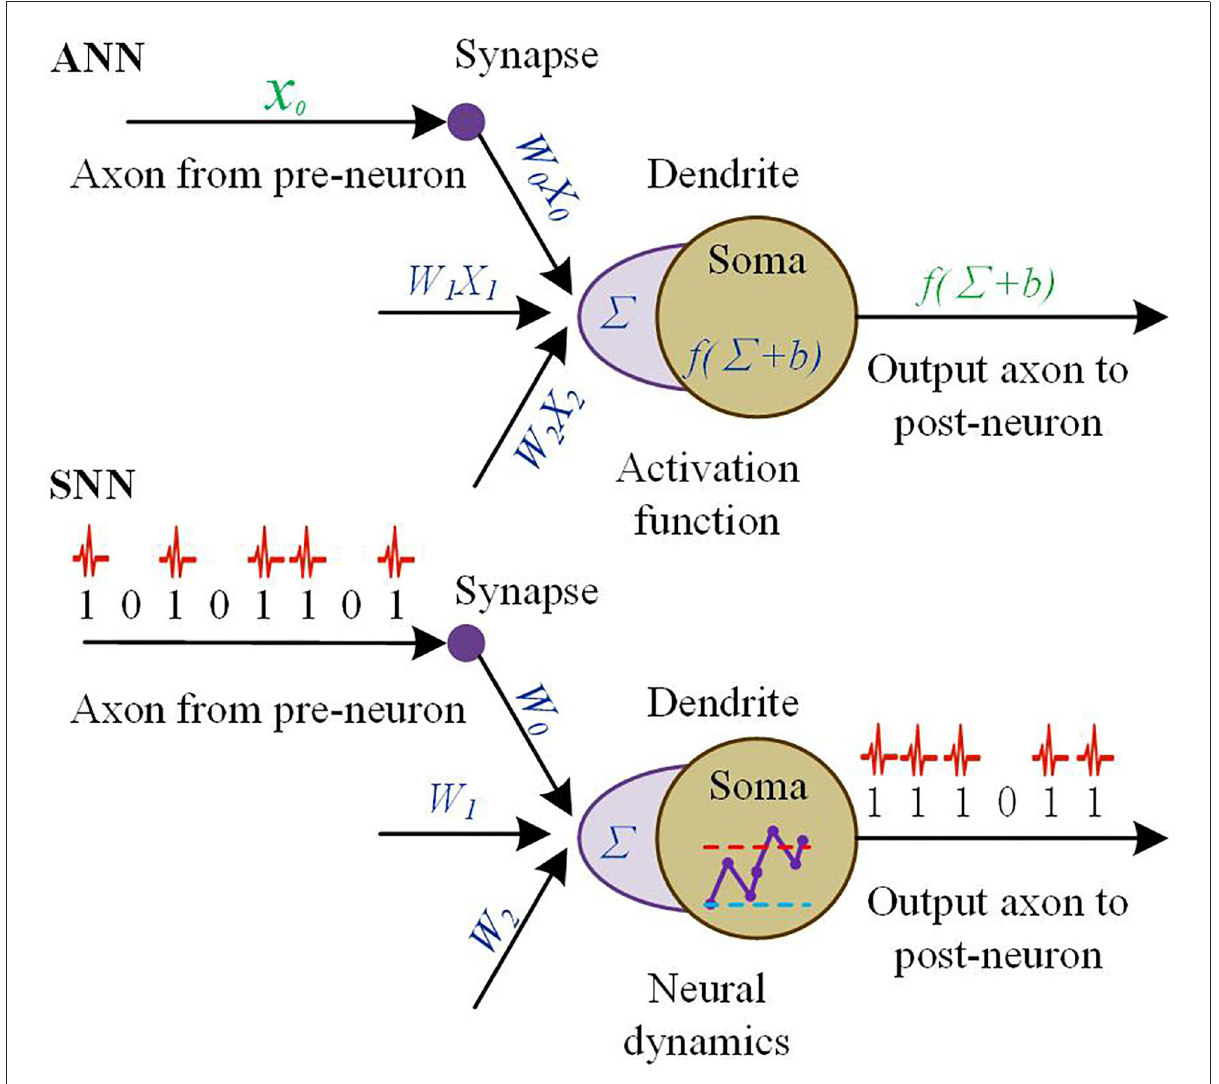
FIGURE4 The unified functional core (Fcore) of the Tianjic chip consists of four main components: axons, dendrites, soma, and